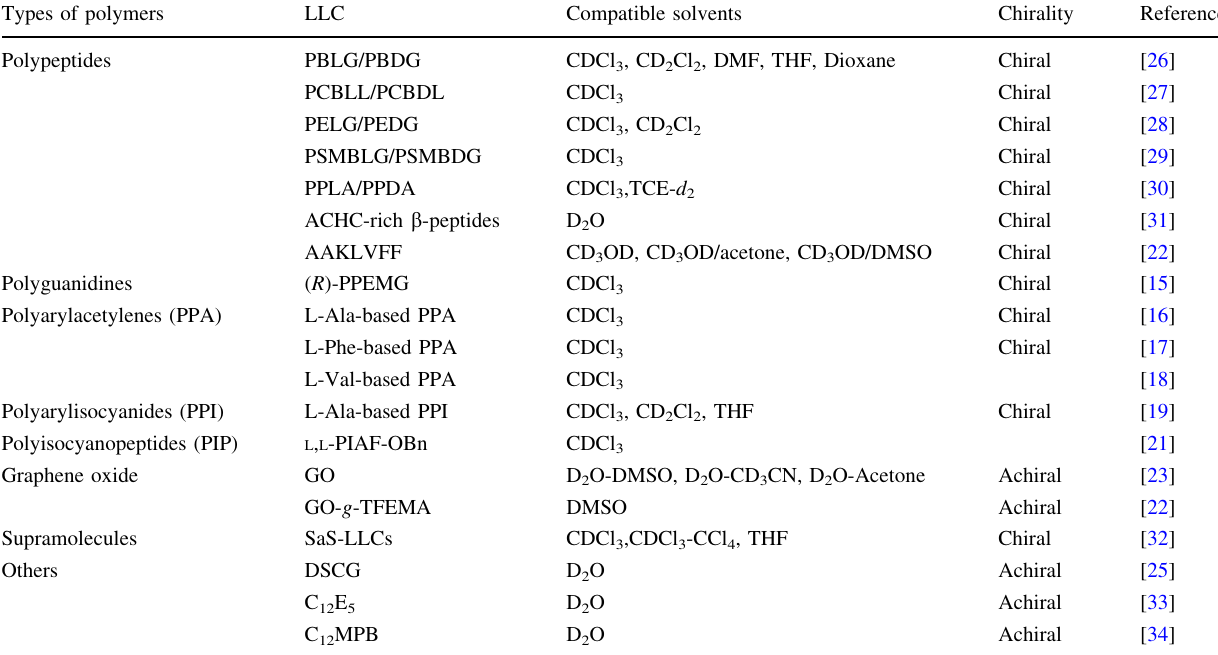
Table 1 The different LLC media according to structure types of polymers Types of